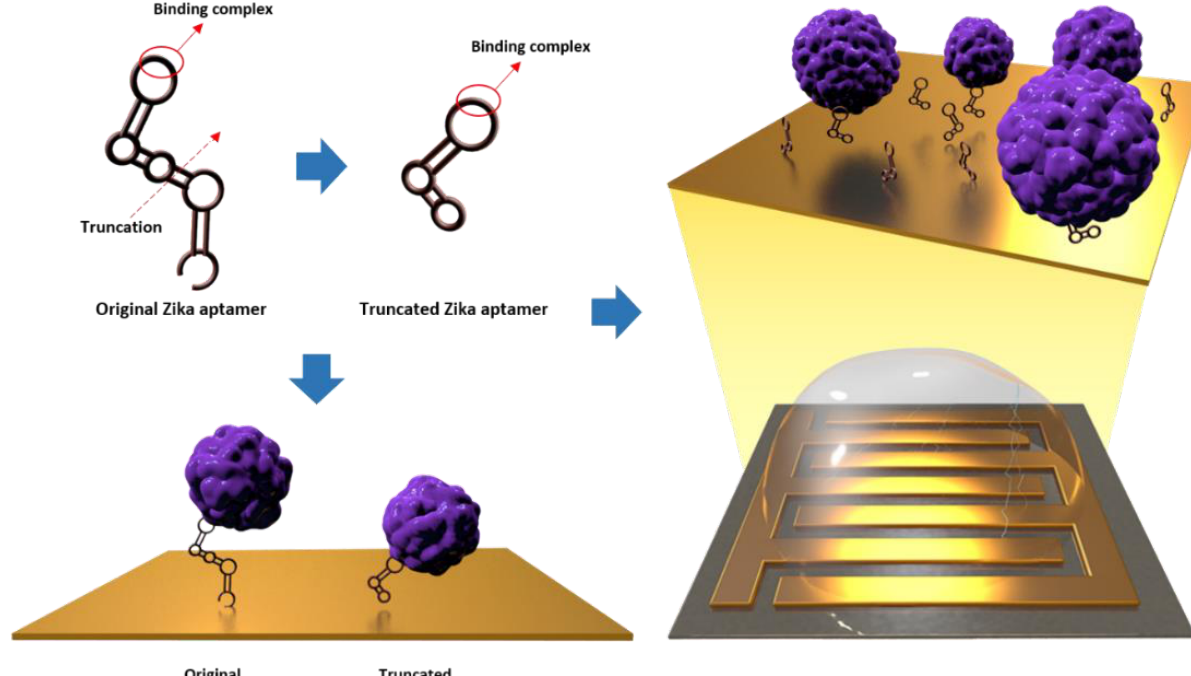
Figure 1. Schematic image of a Zika envelope protein detection biosensor.